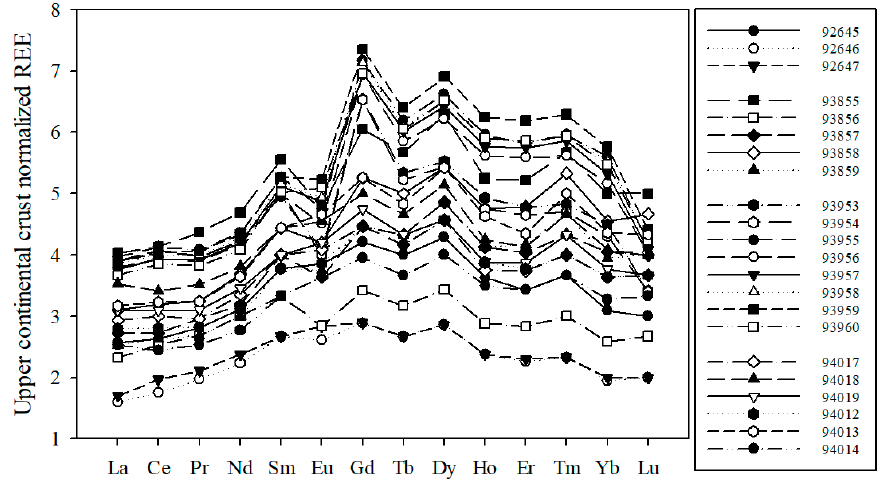
Figure 3. Upper continental crust-normalized REE distribution after Taylor and McLennan [27]. All of the fly ash series are shown on this graph.